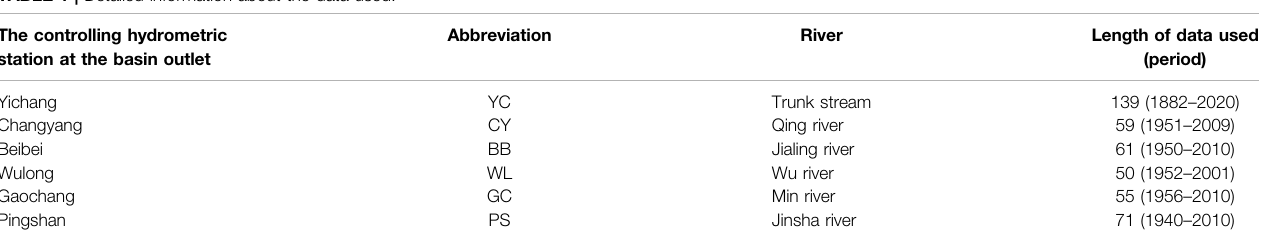
TABLE 1 | Detailed information about the data used. The controlling hydrometric station at the basin